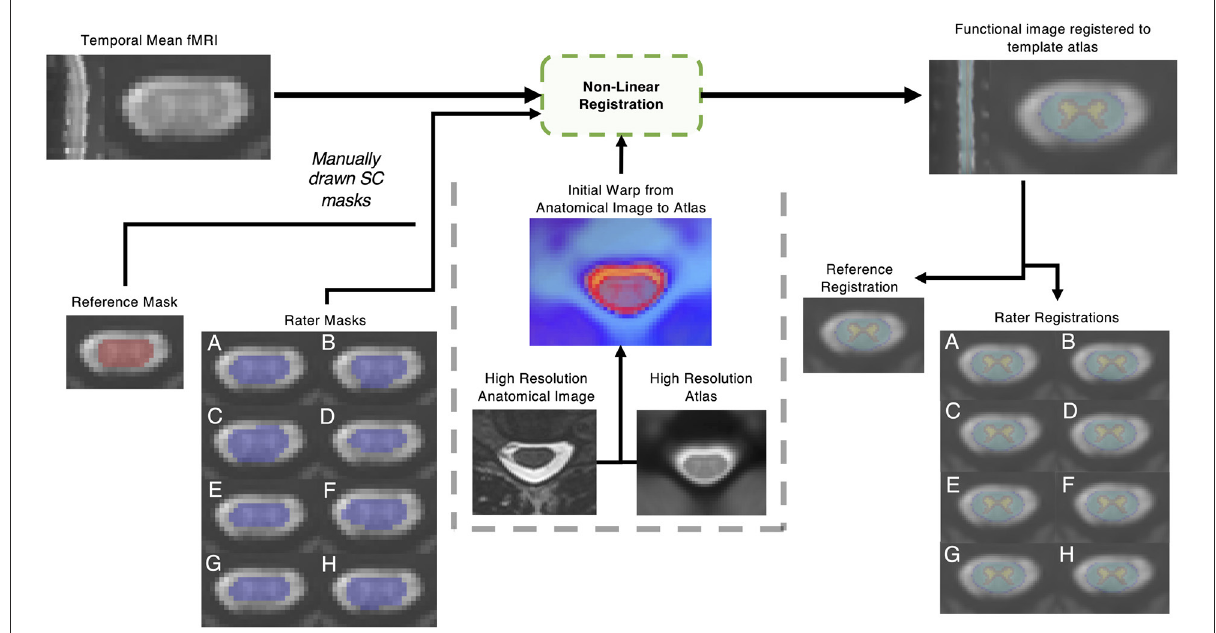
FIGURE1 Outline of non-linear registration. A mean temporal image was created; then a reference rater and 8 raters with varied levels of experience contoured the spinal cord manually. Non-linear registration was performed with the Spinal Cord Toolbox, utilizing additional information from a high resolution anatomical T2 weighted image. The impact of the resulting registration of the functional image to template space was